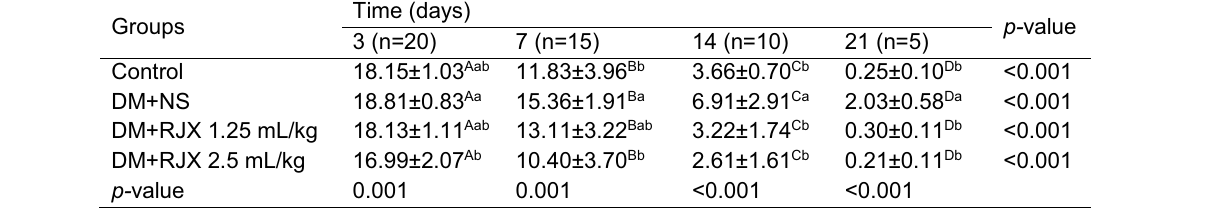
healthy control rats, consistent with delayed wound healing ( Figure 4). In fl ammatory cell in fi ltration in the dermis along with fi brin and cell debris on the epithelial layer persisted for up to 14 days in the DM+NS group but not in the RJX-treated groups. The histopathological score of wound healing on days 7 and 14 was better in diabetic rats treated with 2.5 mL/kg RJX than for diabetic rats treated with NS and comparable to the scores for non-diabetic healthy rats consistent with an accelerated healing process ( Figure 4 ).